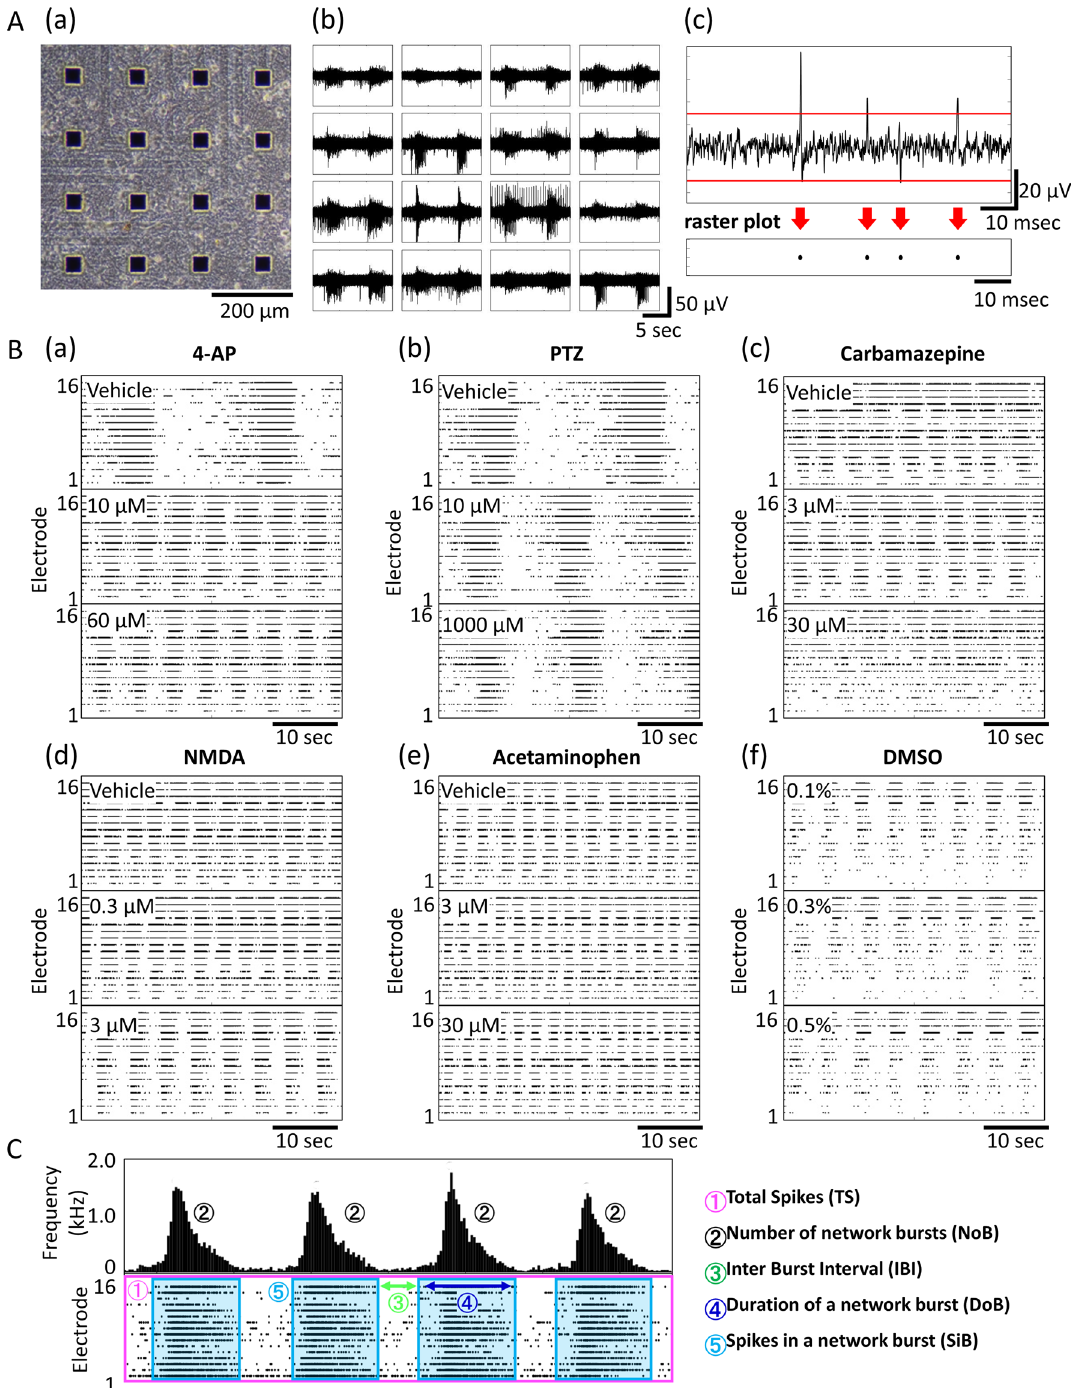
Figure 1. MEA data from a cultured human iPSC-derived neural network. (A) (a) Phase-contrast image of neurons on an MEA chip at 81 days in vitro (DIV). (b) Typical action potential waveform in a spontaneous recording. (c) Upper graph shows the action potential waveform acquired with a single electrode and the voltage threshold for spike detection (red line). Raster plots of detected spikes (black circles) are shown under the graph. (B) Concentration-dependent Raster plot images of typical mechanisms of action (a) 4-AP, (b) carbamazepine, (c) NMDA, (d) PTZ, (e) acetaminophen, (f) DMSO. (C) Schematic diagram of analysis